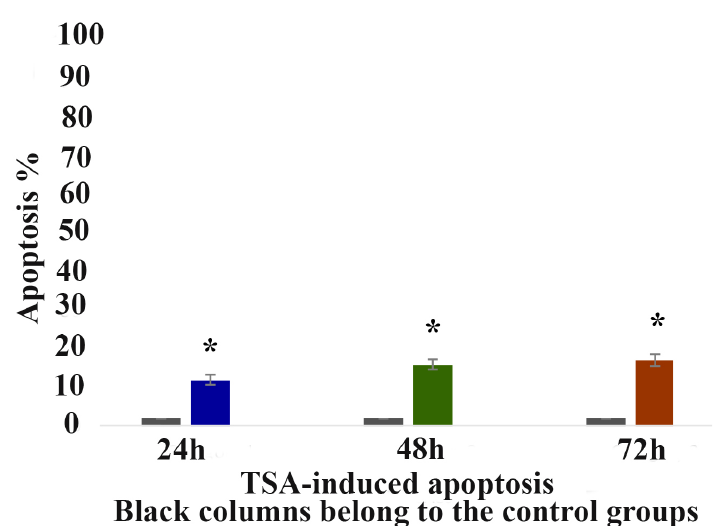
FIGURE 3 – Apoptotic effect of TSA after different time periods.